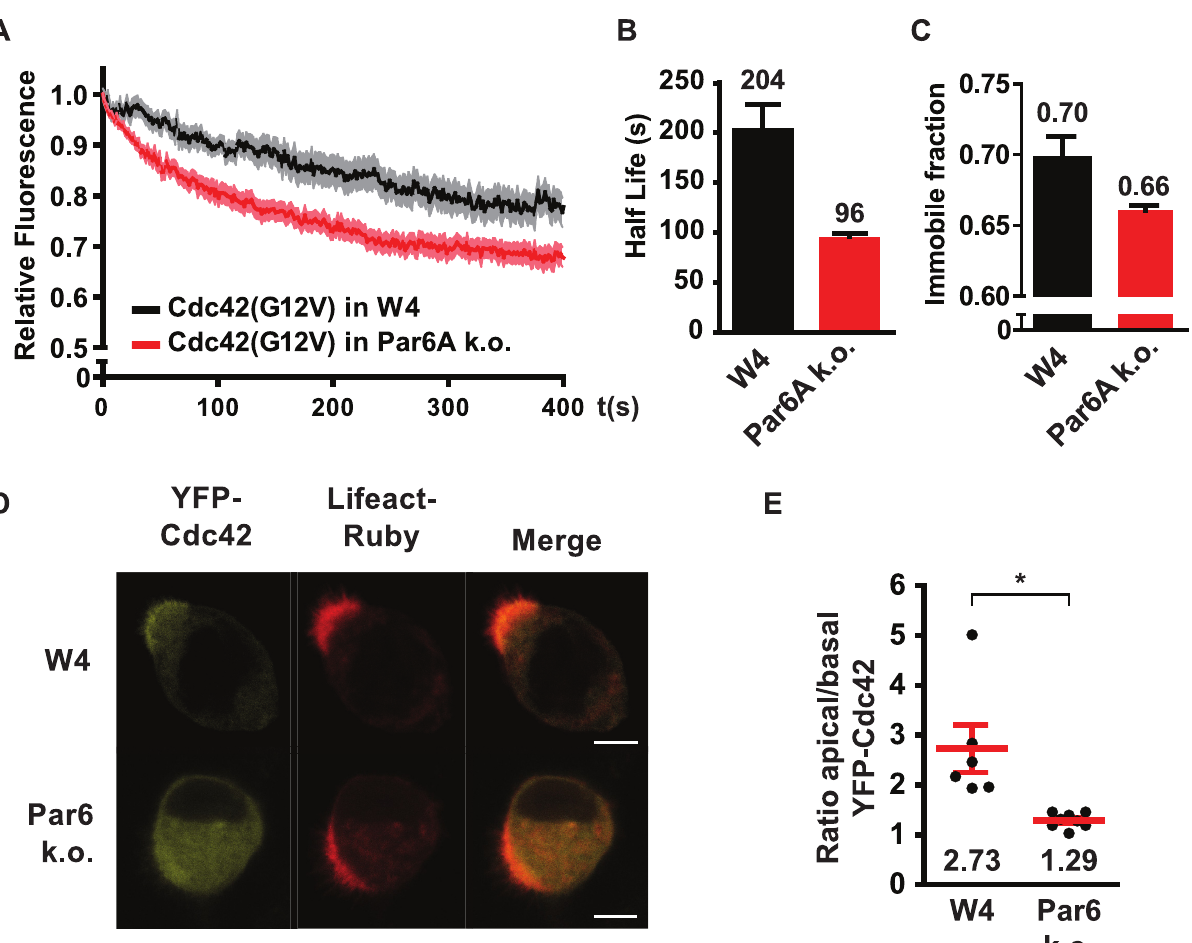
Fig 2. Apical mobility of Cdc42(G12V) is increased in Par6A k.o. cells. A) Average normalized fluorescence decay traces of Dendra-Cdc42(G12V) in polarized Ls174T:W4 cells (black line, n = 12) and Par6A k.o. cells (red line, n = 17). Light area indicates sem. B) Eviction half-lifes for Dendra-Cdc42 (G12V) in polarized Ls174T:W4 cells and Par6A k.o. cells determined from average decay traces in A using curve fitting. Error bars indicate 95% confidence interval of the fit. C) Immobile fractions for Dendra-Cdc42(G12V) in polarized Ls174T:W4 cells and Par6A k.o. cells determined from average decay traces in A using curve fitting. Error bars indicate 95% confidence interval of the fit. D) Representative images of polarized Ls174T:W4 and Par6A k.o. cells expressing YFP-Cdc42 and lifeact-ruby. Scale bars indicate 5 μ m. E) Quantification of apical enrichment of YFP-Cdc42 signal intensity in polarized Ls174T:W4 and Par6A k.o. cells. Red lines indicate the average and s.e.m. (W4: n = 6; Tuba k.o. n = 8). � p < 0.05 using independent samples